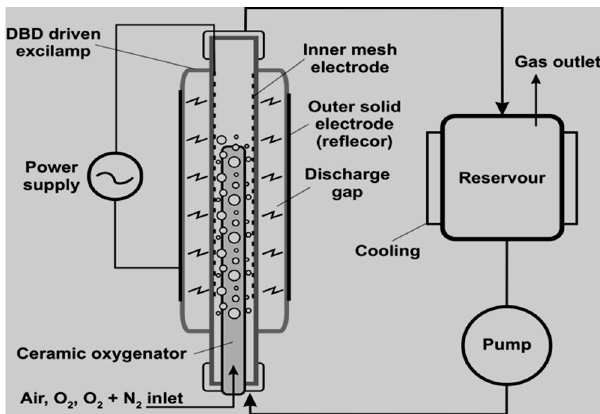
Figure 17. Schematic drawing of set-up with dielectric barrier discharge (DBD) driven Xe 2 -excilamp for UVU photolysis [200].